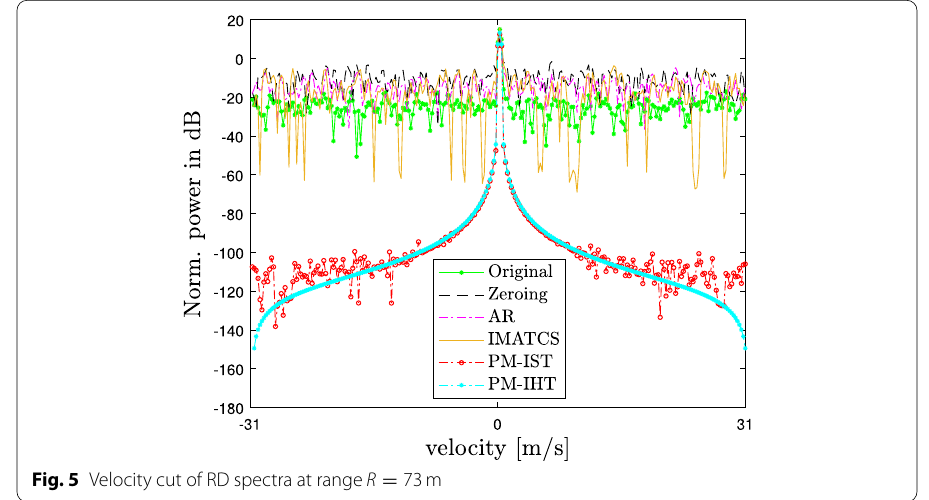
Fig. 5 Velocity cut of RD spectra at range R